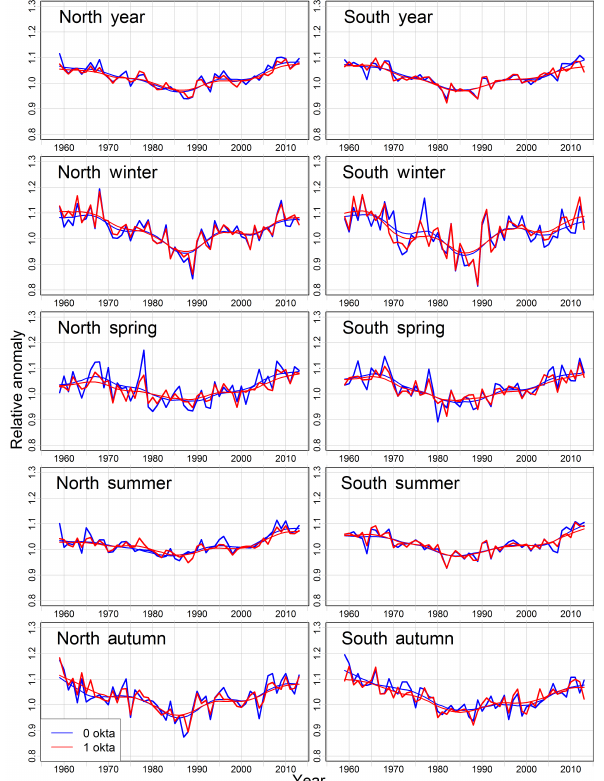
Figure 6. Average annual and seasonal northern (left column) and southern (right column) Italian SSR records obtained under clear- sky conditions (bold lines), plotted together with an 11-year win- dow, 3-year standard deviation Gaussian low-pass filter (thin lines). The series are expressed as relative deviations from the 1976–2005 means. The blue lines represent the records obtained using 0okta of TCC as the threshold to select clear days and the red lines the ones using